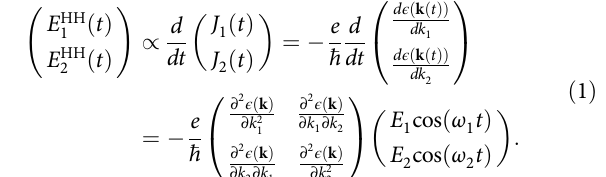
Fig. 1 HHG with two orthogonally polarized optical fi elds. a Experimental setup. Two orthogonally polarized pulses with photon energies ħ ω 1 and ħ ω 2 and fi eld strengths E E 1 and 2 are focused onto the sample (bulk GaSe with a thickness of 30 are decomposed along the two mutually orthogonal directions of the electric fi elds E 1 ( t ) and E 2 ( t ), and their intensities, I HH function of the crystal rotation angle φ (rotation axis: pulse propagation direction). b The I HH excitation with E 1 ( t ) ( red data), E 2 ( t ) (blue data), and E 1 ( t ) + E 2 ( t ) (purple data) for φ = 15°. To distinguish the different mixed harmonic orders, we use ordered pairs, ( m , n ). Photoluminescence (PL) appears around 2 eV 31 . c Harmonic intensities as a function of E 1 for the harmonic orders ( m , n ) = (4,1), (2,2), (3,0), (2,1), (1,2) (solid circles), while E 2 = 0.5 MV/cm. The black broken lines are proportional to E 2 m and serve as guides for the eye. The data sets are offset for clarity. Inset: E 2 dependences of the (4,1)-, (2,2)-, (1,2)- and (2,1)-order harmonics ’ intensities, while E 1 = 5 MV/cm; the black broken lines are proportional to E 2 n